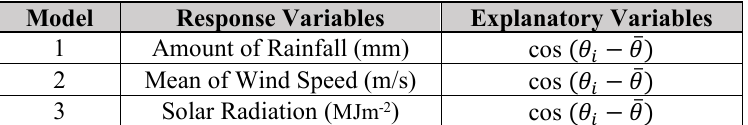
Table 2. Details of fitted